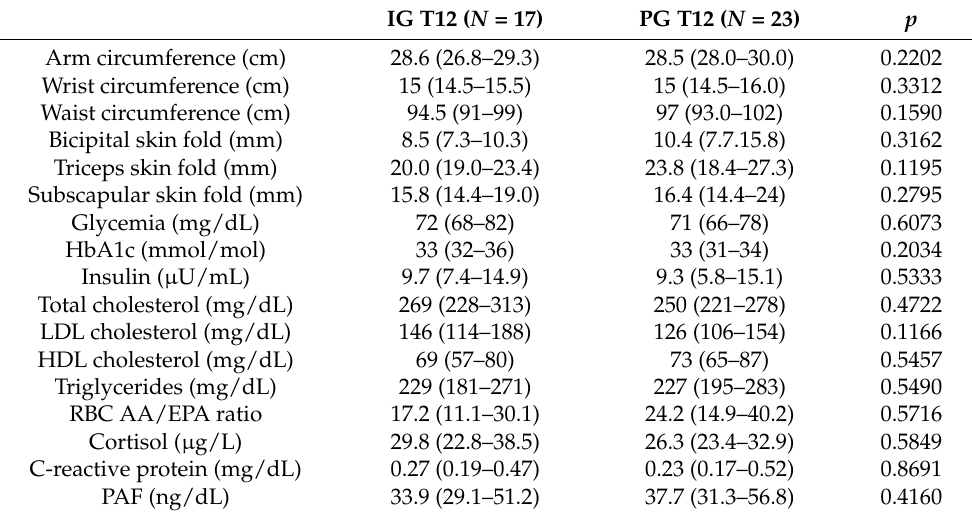
Table 1. Anthropometric, metabolic, and inflammatory parameters at T12 of the intervention group and the placebo